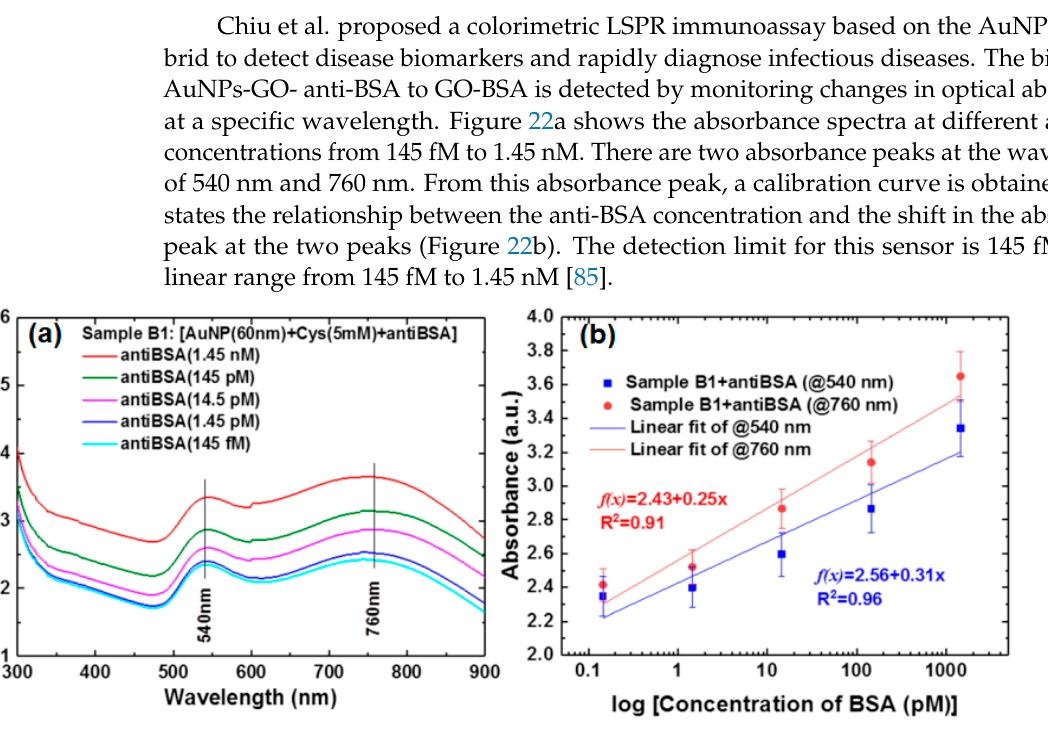
Figure 21. ( a ) SPR response at three different nanoparticles (Au film, Au-Gra, Ag-Gra). ( b ) The selectivity of the SPR on three different analytes (human IgG, bovine IgG, and mouse IgG) (adapted with permission from Reference [84], copyright Elsevier).